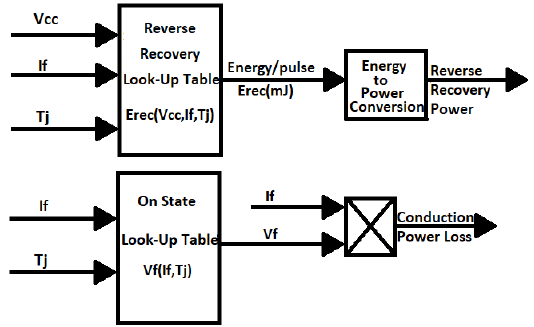
Figure 12. Reversed diode power losses calculation using look-up